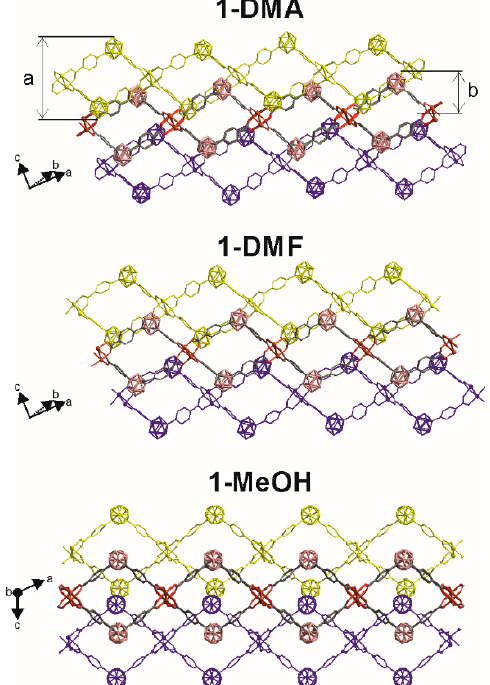
Figure 2. View of the packing structures for 1-Solv (Solv = DMA, DMF, and MeOH) showing the staking of 2D layer structures in which the various colors differentiates the contiguous layers. Coordinated solvent molecules are omitted for clarity. Layer thickness (a) and Interlayer distance (b) are only represented in 1-DMA. See Table 1 for values for all the structures.